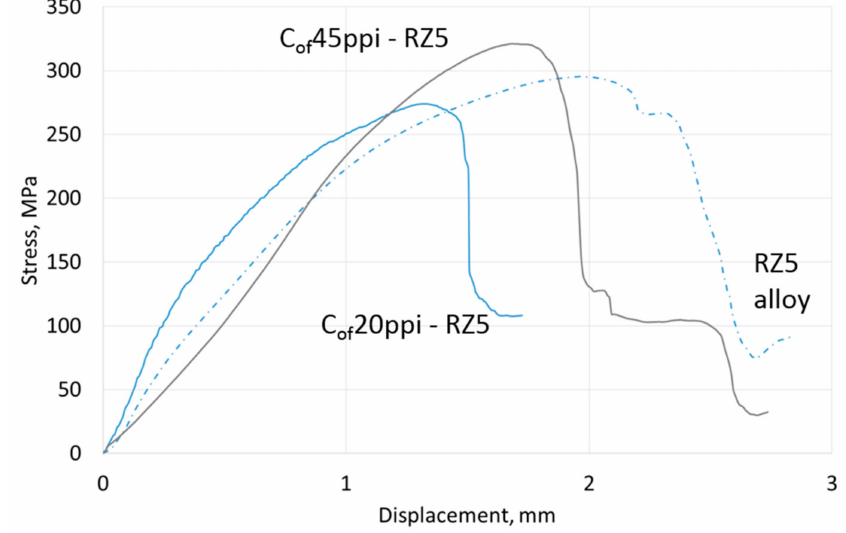
Figure 8. Representative curves obtained in compressive strength tests of RZ5 matrix composites with C of 20ppi and C of